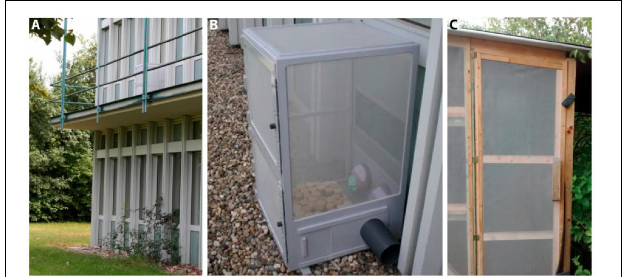
FIGURE 2 | Location of the vials during the outdoor experiment in the summer months. (A) and (B) show the location at the Biocenter, 1st floor, (C) the sheltered location at the Bee station of the University of